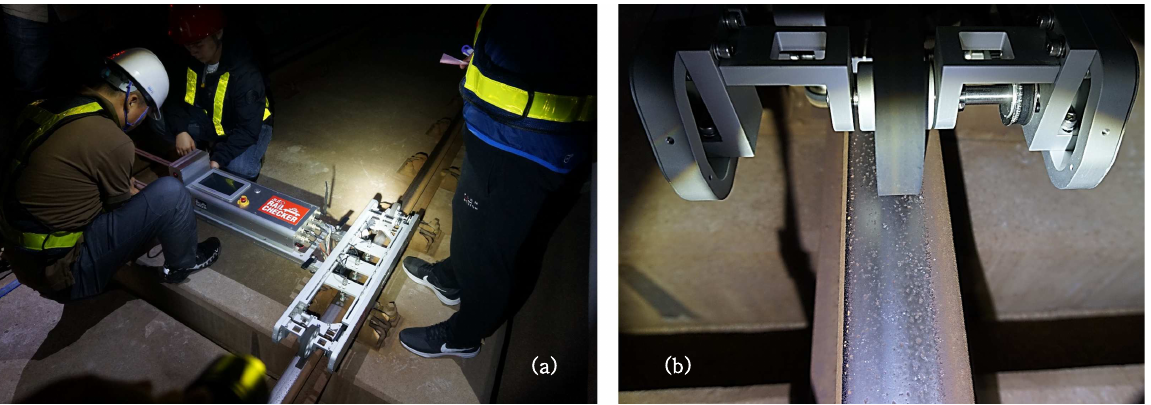
Figure 14. Field measurement of the track A; ( a ) Device setup; ( b ) operating wheel and